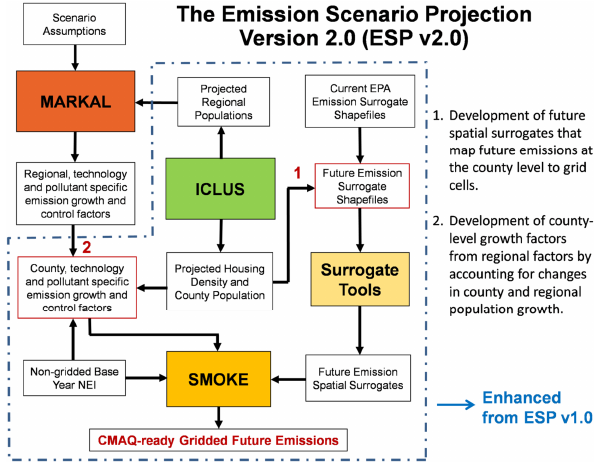
Figure 1. Schematic diagram showing components of the Emis- sion Scenario Projection v2.0 system. Dashed blue box contains enhancements from ESP